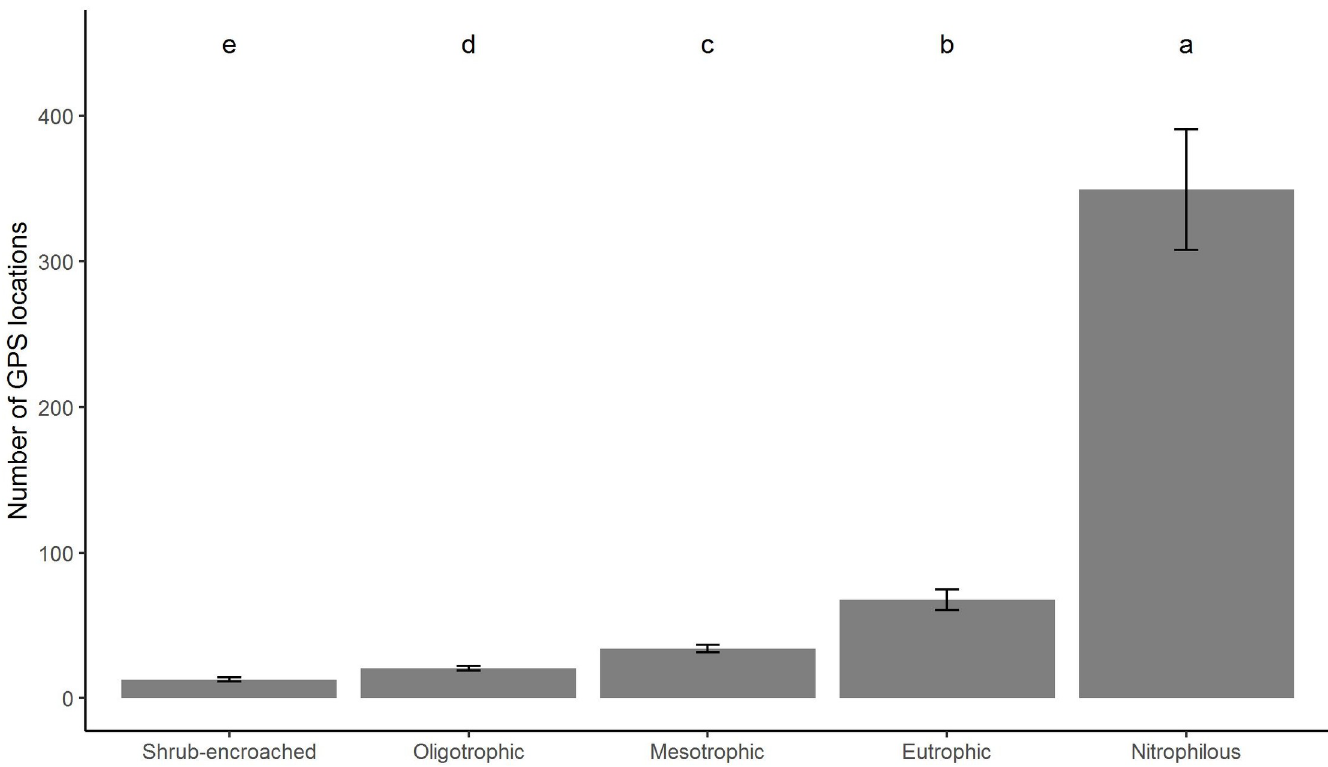
Fig 4. Mean number of GPS locations for each Vegetation Ecological Group at the farm-scale study. Error bars represent the standard error of the mean, whereas letters above histograms indicate significant differences according to Tukey’s post-hoc test with Bonferroni-adjusted p -values.